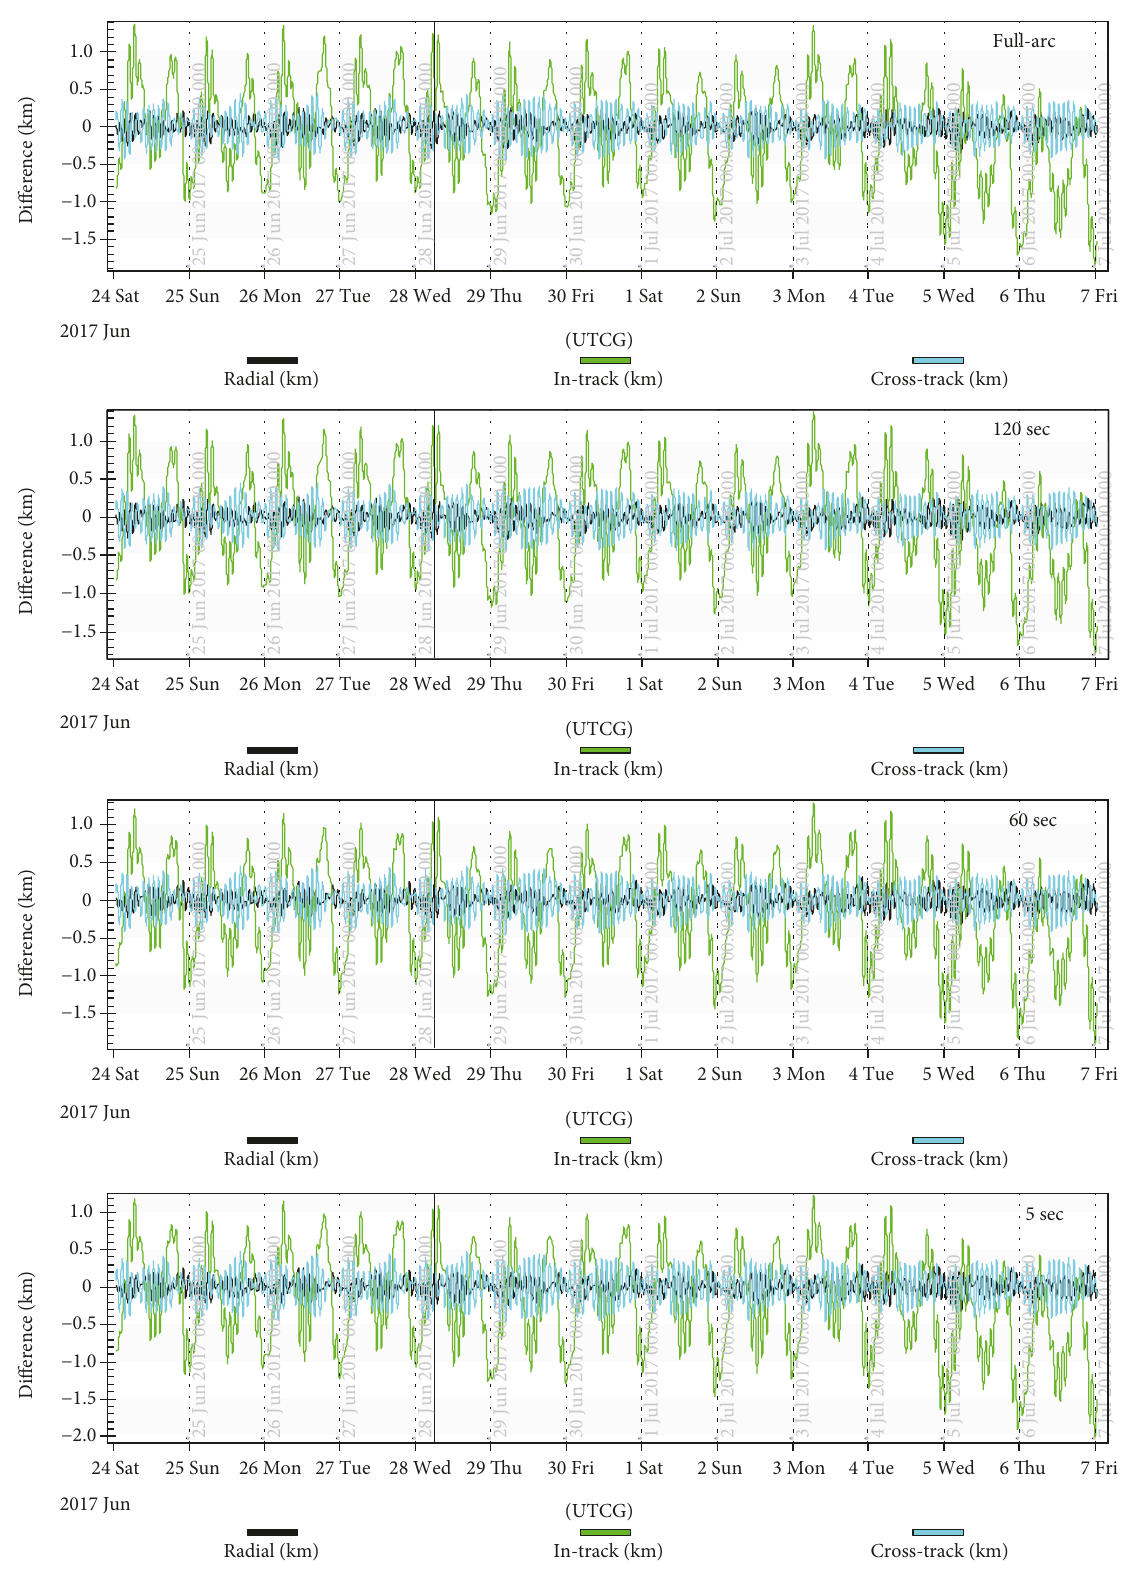
Figure 8: Comparison on the RIC frame with estimated orbit and consecutive TLEs for full-arc, 120s, 60 s, and 5 s cases ( fi rst seven days: estimated orbit, last seven days: propagated